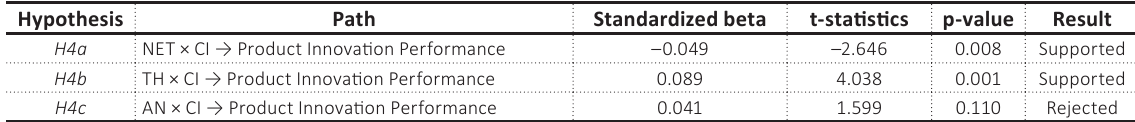
Table 4. Summary of moderating effect of competitive